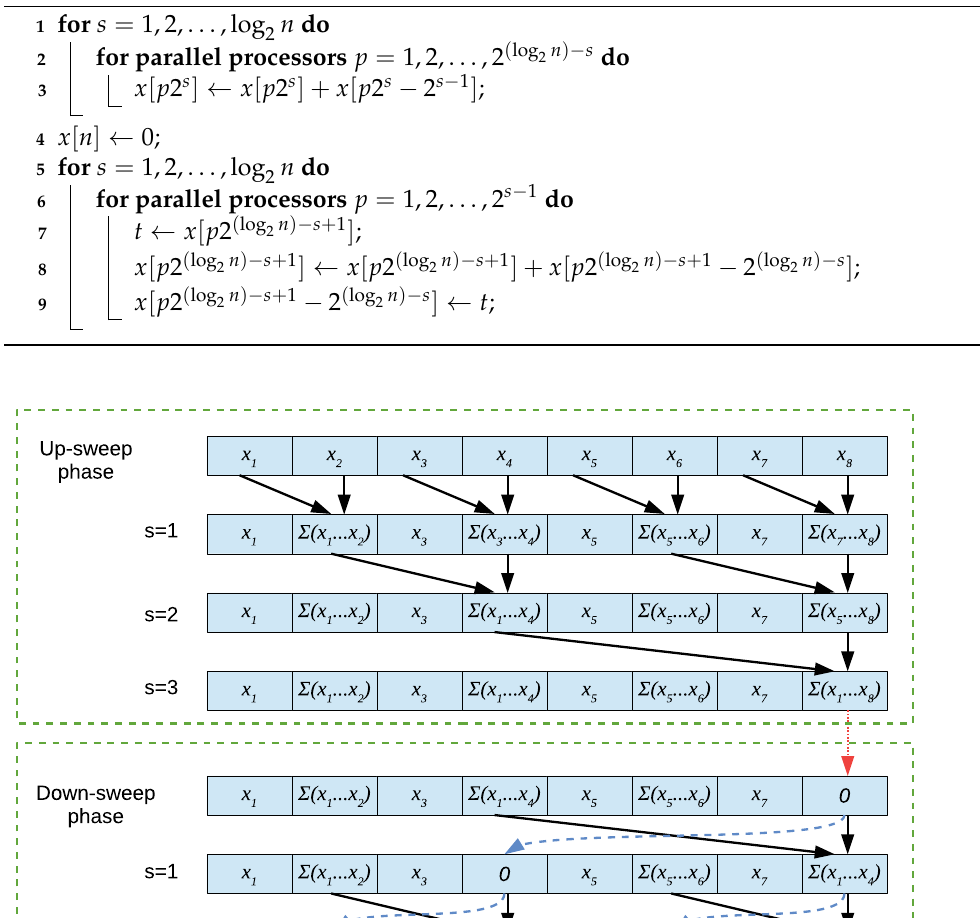
Algorithm 2: Work-efficient exclusive parallel prefix sum computation